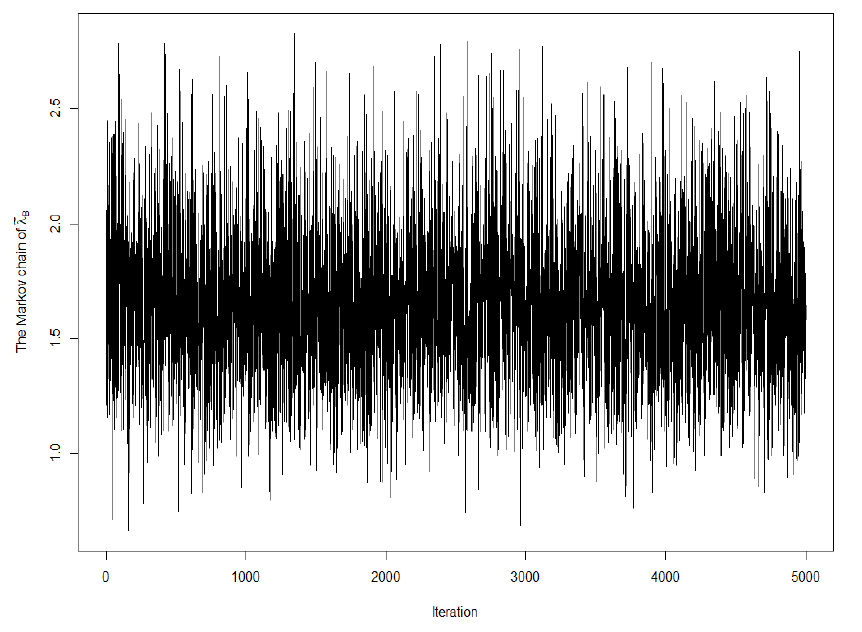
Figure A2. The Markov chain with 5000 iterations of ˜ λ BE after